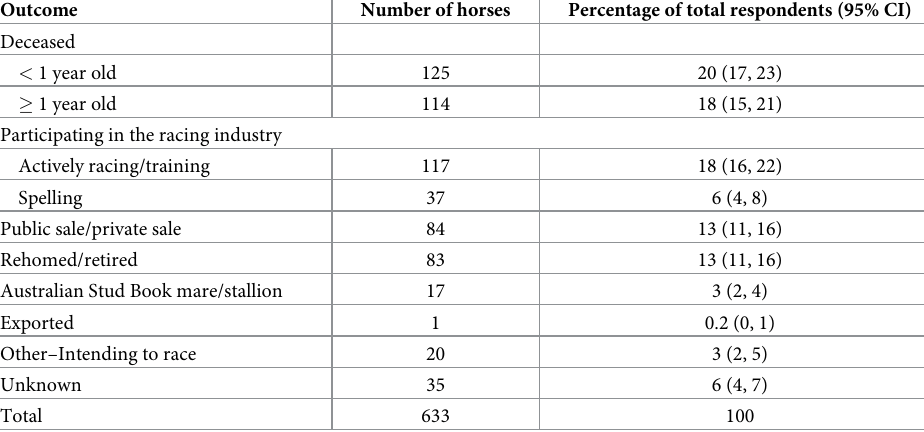
Table 1. Outcomes of surveyed